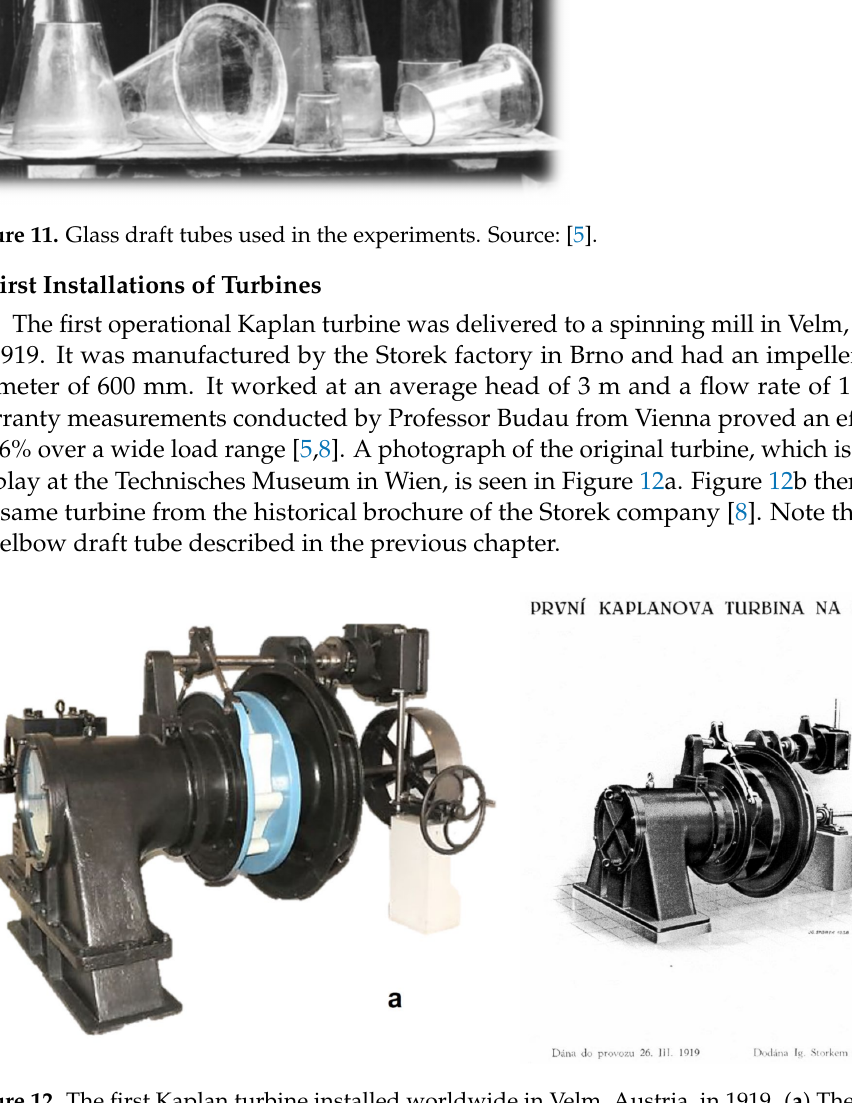
Figure 12. The first Kaplan turbine installed worldwide in Velm, Austria, in 1919. ( a ) The original turbine, now exhibited in the Technisches Museum in Wien, ( b ) the historical brochure of the Storek company. Source: